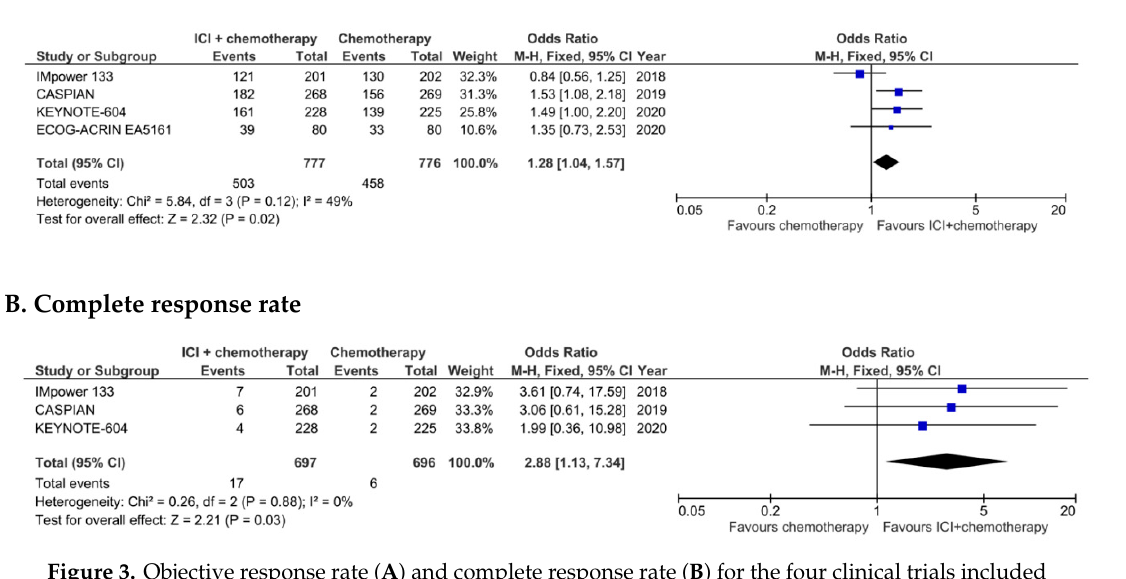
Figure 3. Objective response rate ( A ) and complete response rate ( B ) for the four clinical trials included in the meta-analysis, in the intention-to-treat populations. M-H: Mantel-Haenszel; 95% CI: 95% confidence